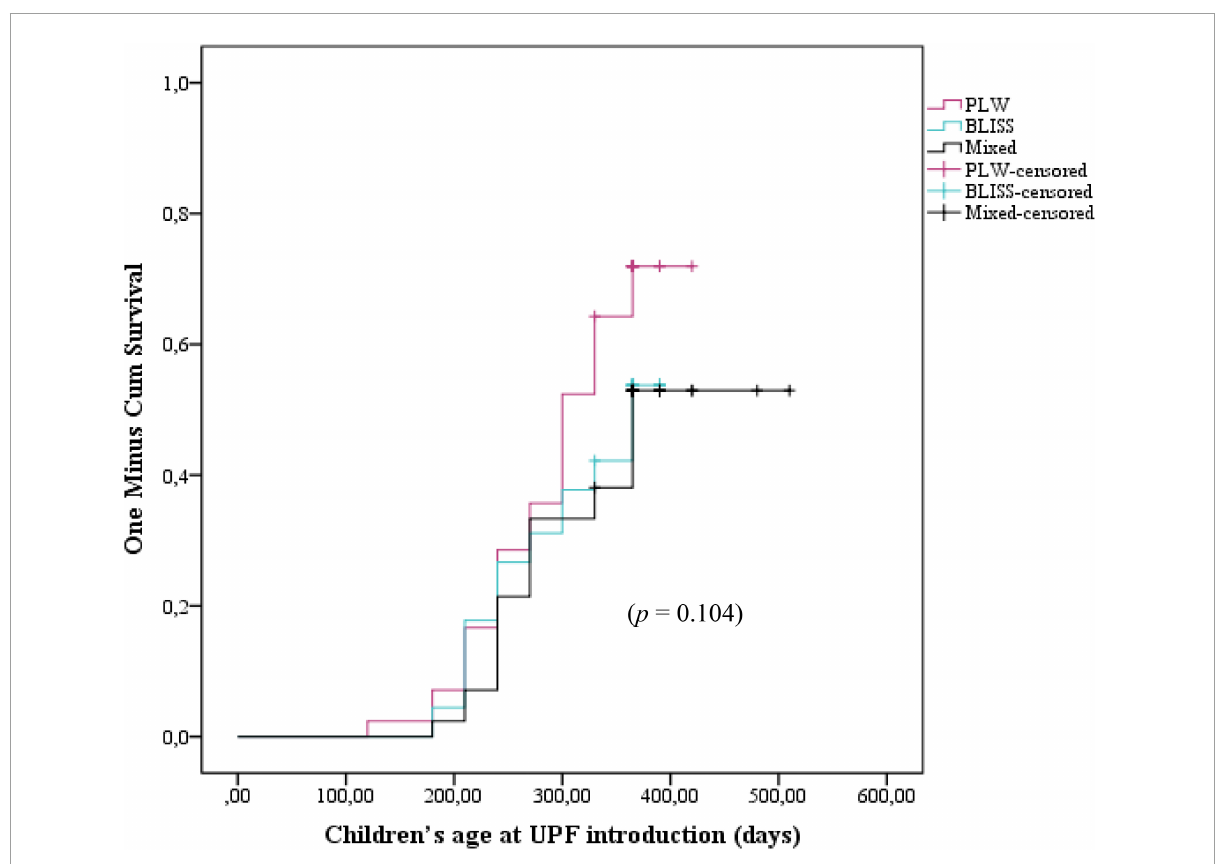
FIGURE3 Kaplan–Meier curve displaying the probability of being introduced to ultra-processed foods in the first year of children’s life according to interventions: PLW, BLISS, and mixed groups, Brazil, 2019–2021. PLW, parent-led weaning; BLISS, baby-led introduction to